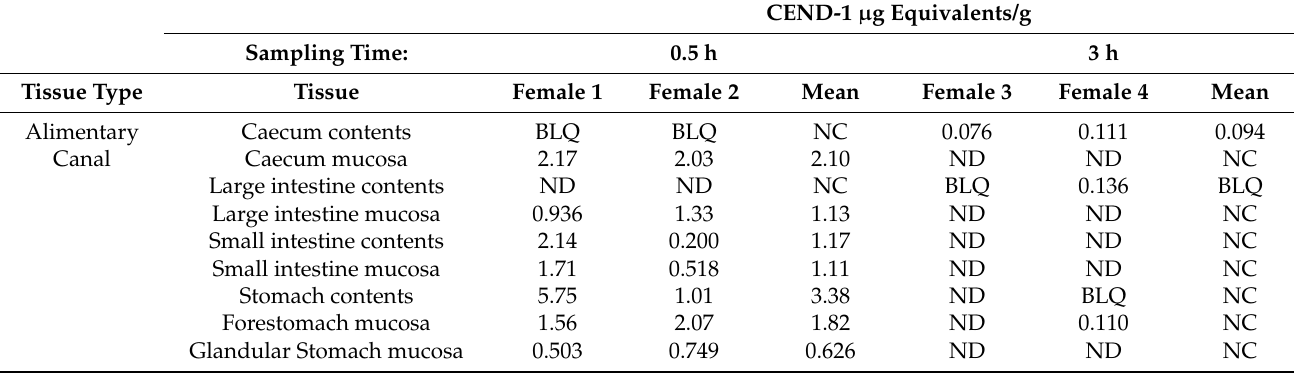
Table 3. Distribution of radioactivity in tissues of perfused female BALB/c mice following a single intravenous dose administration of [ 3 H]-CEND-1 at a target dose of 5